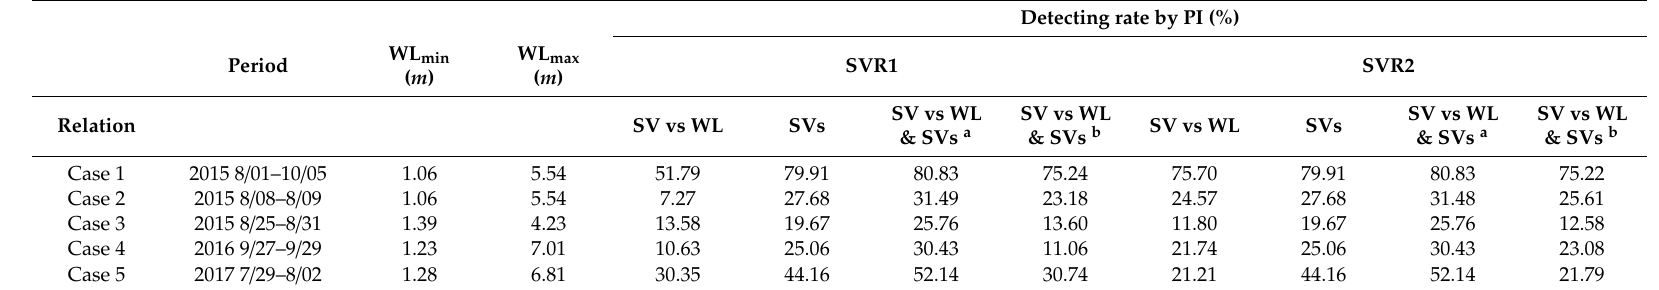
Table 5. Detection rate for di ff erent events during 2015–2017 at Wulilin Bridge.